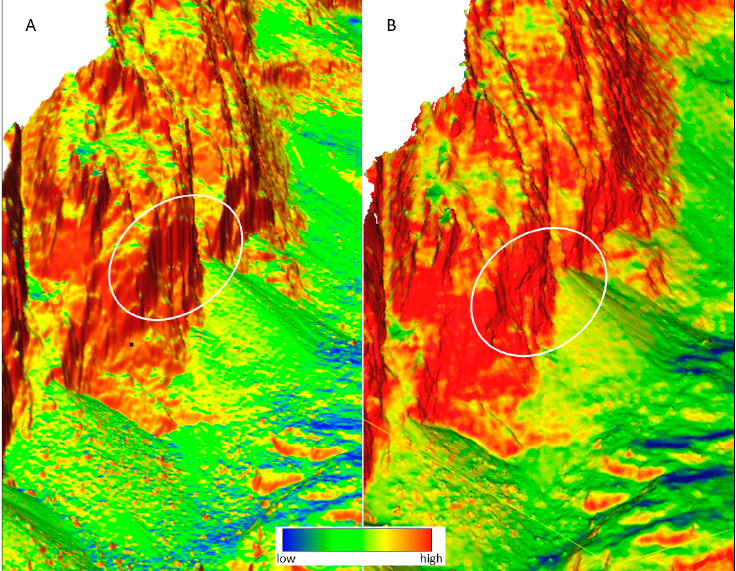
Figure 15. Normalised gradient of elevation of a detailed view showing vertical walls and overhangs as represented by ( A ) the raster-based DEM and by ( B ) a 3D mesh.